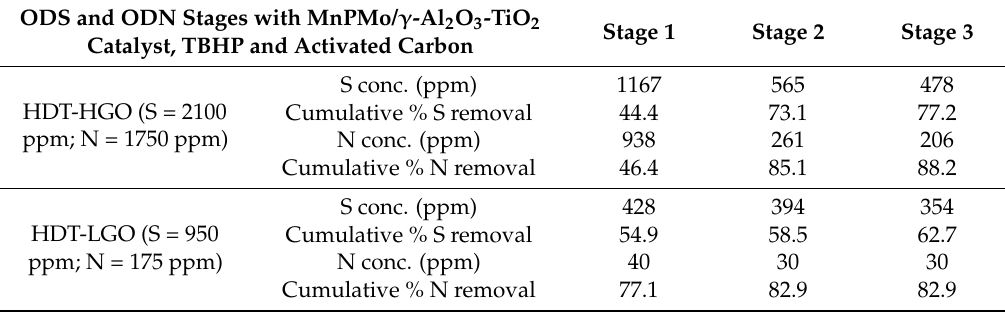
Table 5. Multistage ODS and ODN of hydrotreated gas oils. (error ± 4 ppm). ODS and ODN Stages with MnPMo/ γ -Al 2 O 3 -TiO